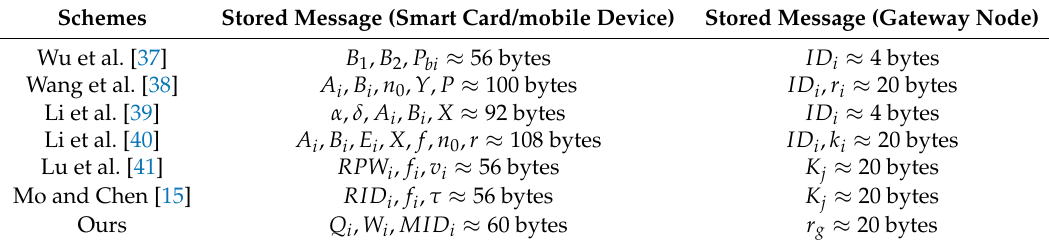
Table 7. Storage overheads